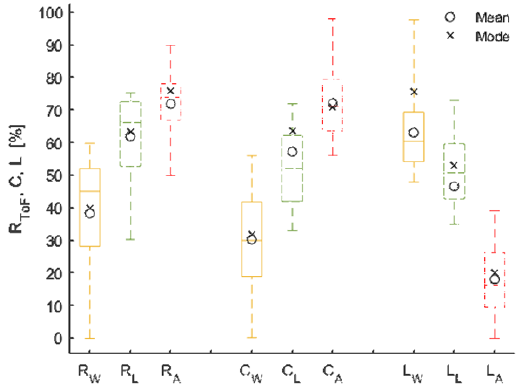
Figure 6. Box-Whisker plot of segmented points of wood (W), leaves (L) and apples (A) based on reflectance (R ToF ), curvature (C) and linearity (L) showing the mean and mode values, maximum, minimum, standard deviation are represented by lower and upper edges of the box, the dash in each box indicates the median.